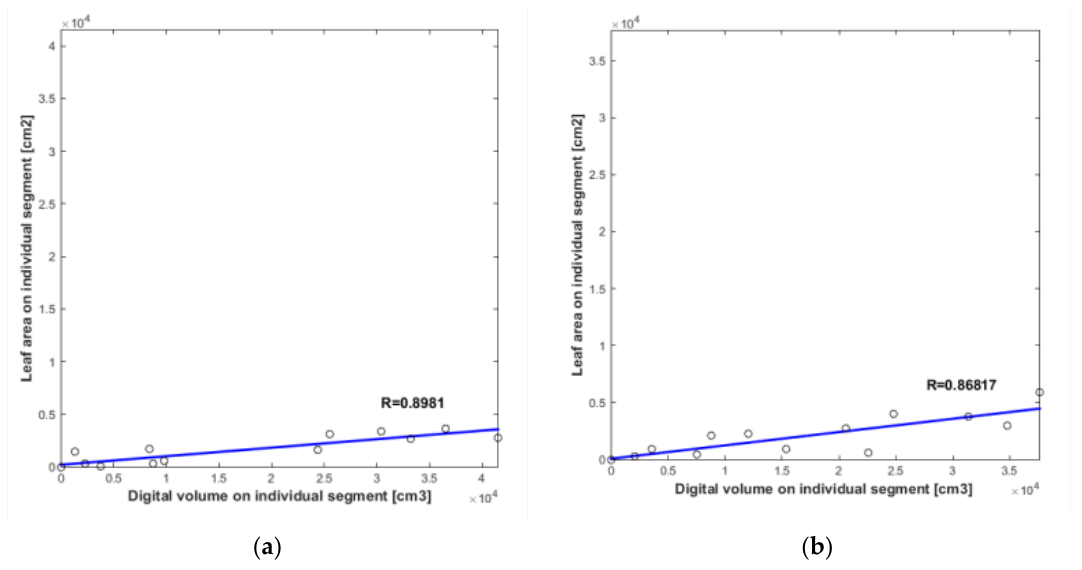
Figure 13. Correlation between number of points in segment (lidar measurements) and leaf area in segment (manual measurements): ( a ) left side of canopy and ( b ) right side of canopy. Correlation was performed for all 12 segments. R = 0.90 for the right side. Here, the better correlation on the left side was most likely the result of more homogeneous canopy growth on the shaded side.